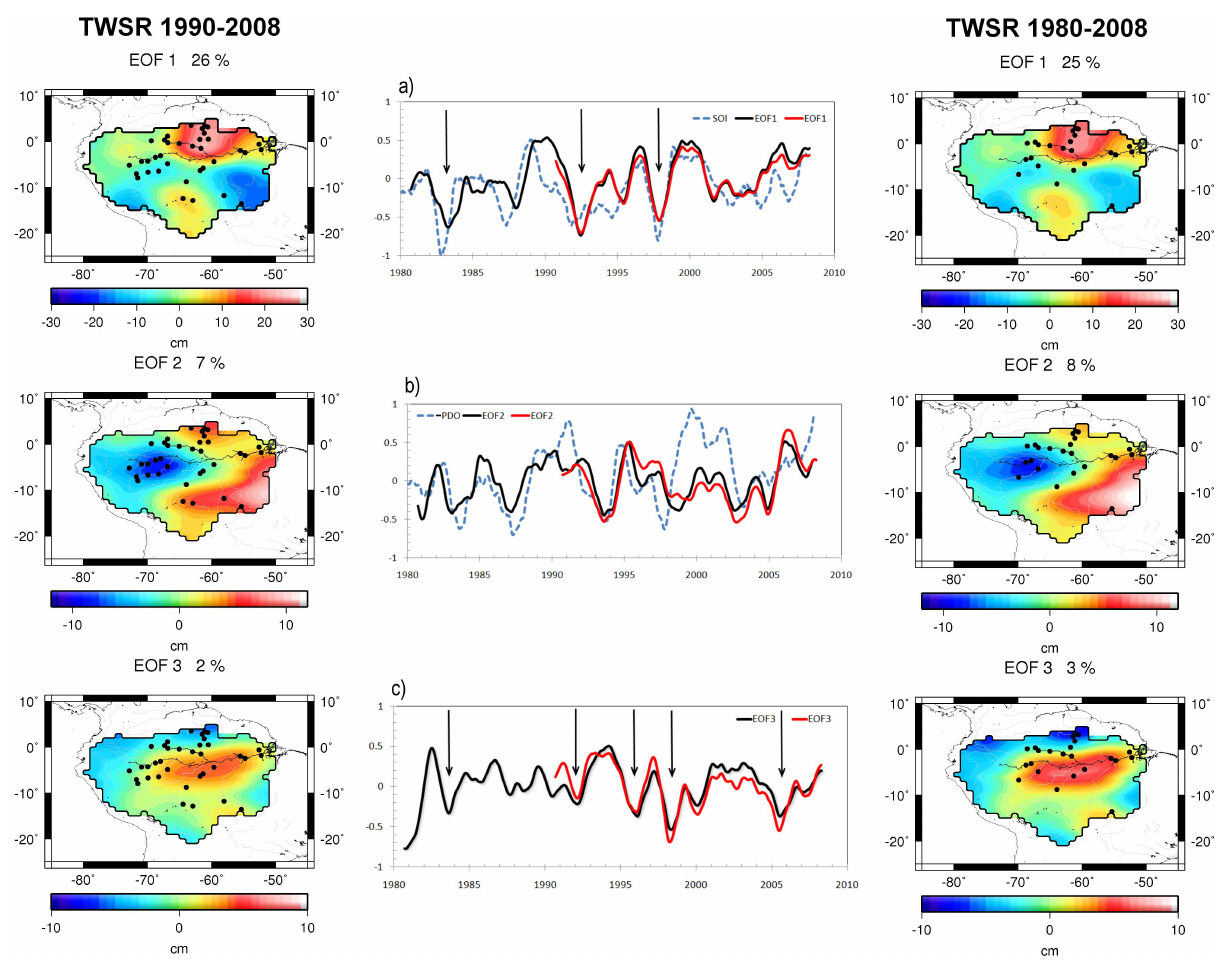
Fig. 8. EOF analysis of TWSR. The left panel shows the EOF analysis for the TWSR over 1990–2008. The locations of the 36 in situ stations used for the reconstruction are indicated by black dots. The right panel shows the EOF analysis for the TWSR over 1980–2008. The locations of the 23 in situ stations used for the reconstruction are indicated by black dots. The middle panel shows the EOFs’ time series computed on the TWSR over 1990–2008 in red line and in black line over 1980–2008, and superimposed (a) the scaled SOI index (dash line) and the El Ni˜no events (arrows), (b) the inverse scaled PDO index (dash line) and (c) the drought events (arrows). We filter out the high frequencies ( > 1yr − 1 ) using a simple 12-month running